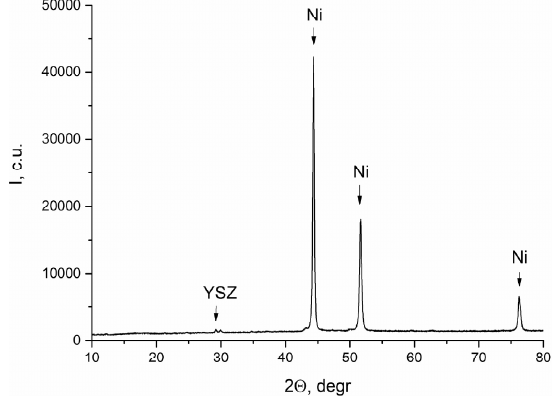
Fig.1. XRD pattern for specimen 2 after